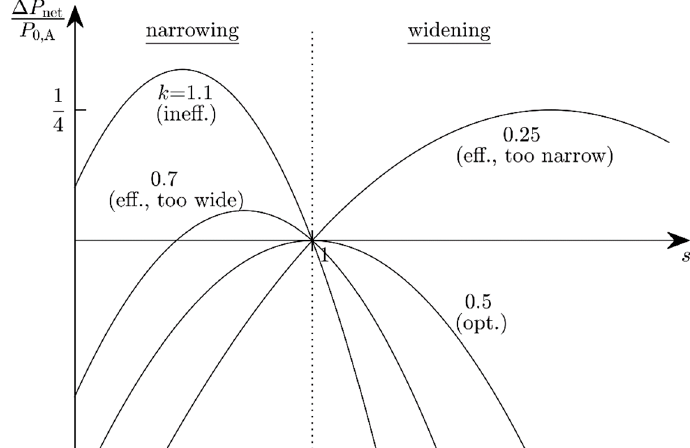
Figure 6. The change ∆ P net in net available power as a function of the adjustment-bandwidth scaling (ABS) factor s with the power ratio k (=adjustment power divided by power harvested prior to the ABS) as a parameter.